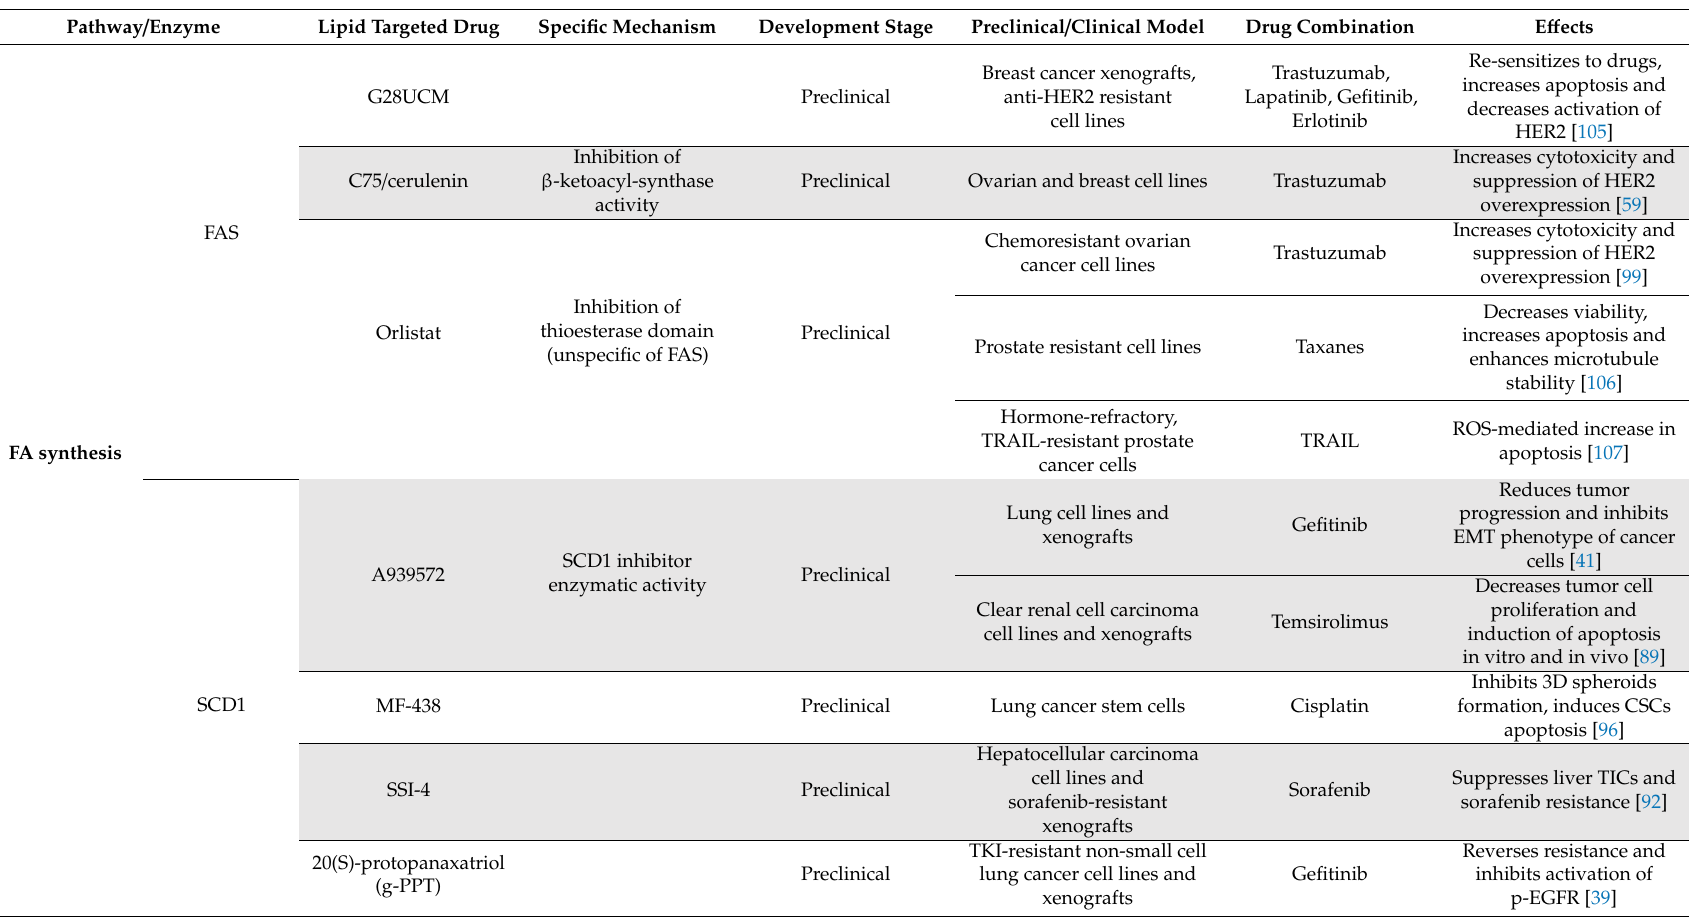
Table 2. Non-exhaustive list of drugs targeting lipid metabolism used in association with standard treatments in resistant cancer. Pathway /